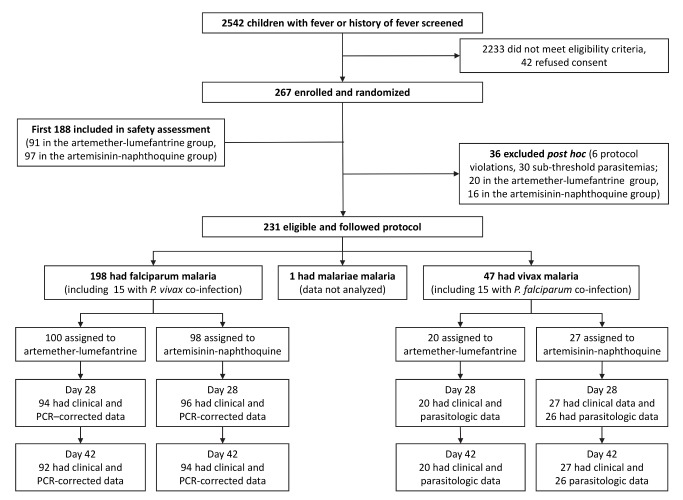
Trial profile showing numbers of patients remaining in the study from screening to day-42 assessment.PCR-corrected denotes correction for reinfections identified by polymerase chain reaction genotyping of polymorphic parasite loci.